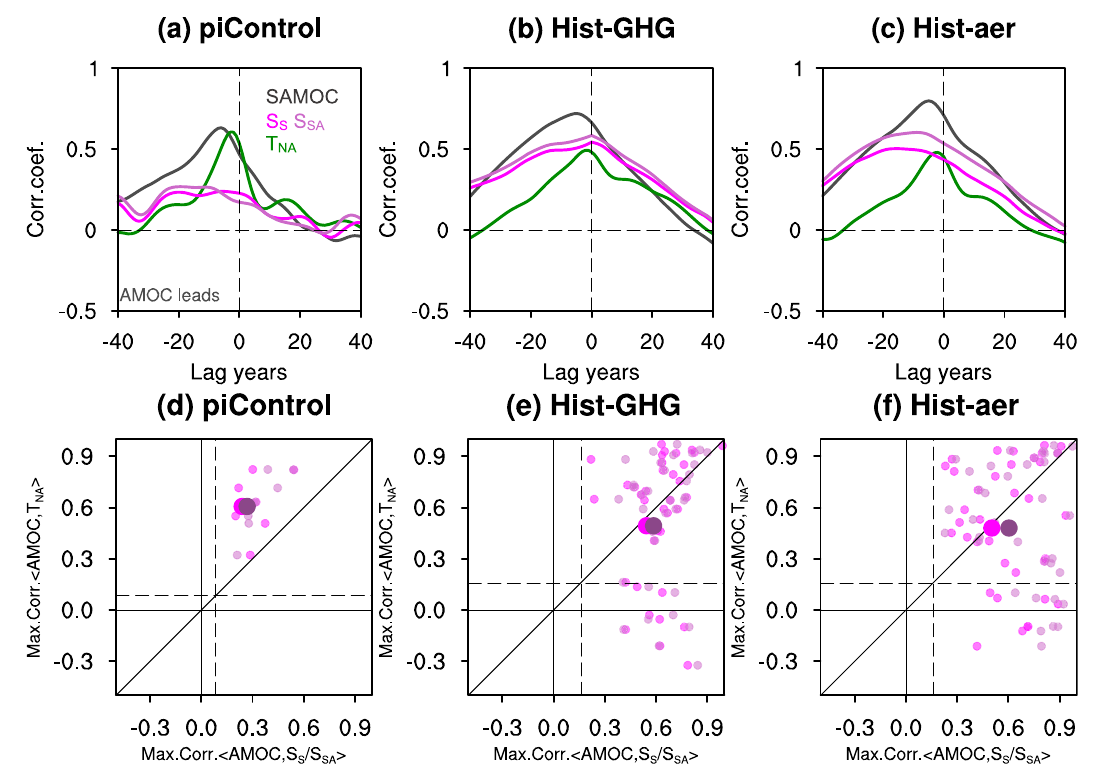
Fig.3|Lead-lagcorrelation.a – c Lead-lagcorrelationbetweenAtlanticmeridional Small magenta (S S versus T NA ) and orchid(S SA versus T NA ) dots are for each CMIP6 overturning circulation ( AMOC) intensity and southern AMOC intensity (gray), model member while big ones are for the ensemble mean. Vertical and horizontal AMOCand the warming hole fi ngerprint T NA (green),AMOCand the salinity-based dashedlinesin( d – f )indicatethe95%signi fi cancelevel(determinedbyMonteCarlo fi ngerprint S fi ngerprint S method) for SSS indices (with a lag of 20 years) and for T NA (with a lag of 5 years), S (magenta), AMOC and the salinity-based SA (orchid) for piControl ( a ), Hist-GHG ( b ) and Hist-aer ( c ) simulations. Time series is 11 years respectively. For piControl simulation, the signi fi cance level is the averaged value locally weighted scatterplot smoothing (LOWESS) fi ltered. d – f Scatter diagram of over the seven simulations with different lengths (Table maximum correlations between AMOC fi ngerprints and AMOC when AMOC leads.